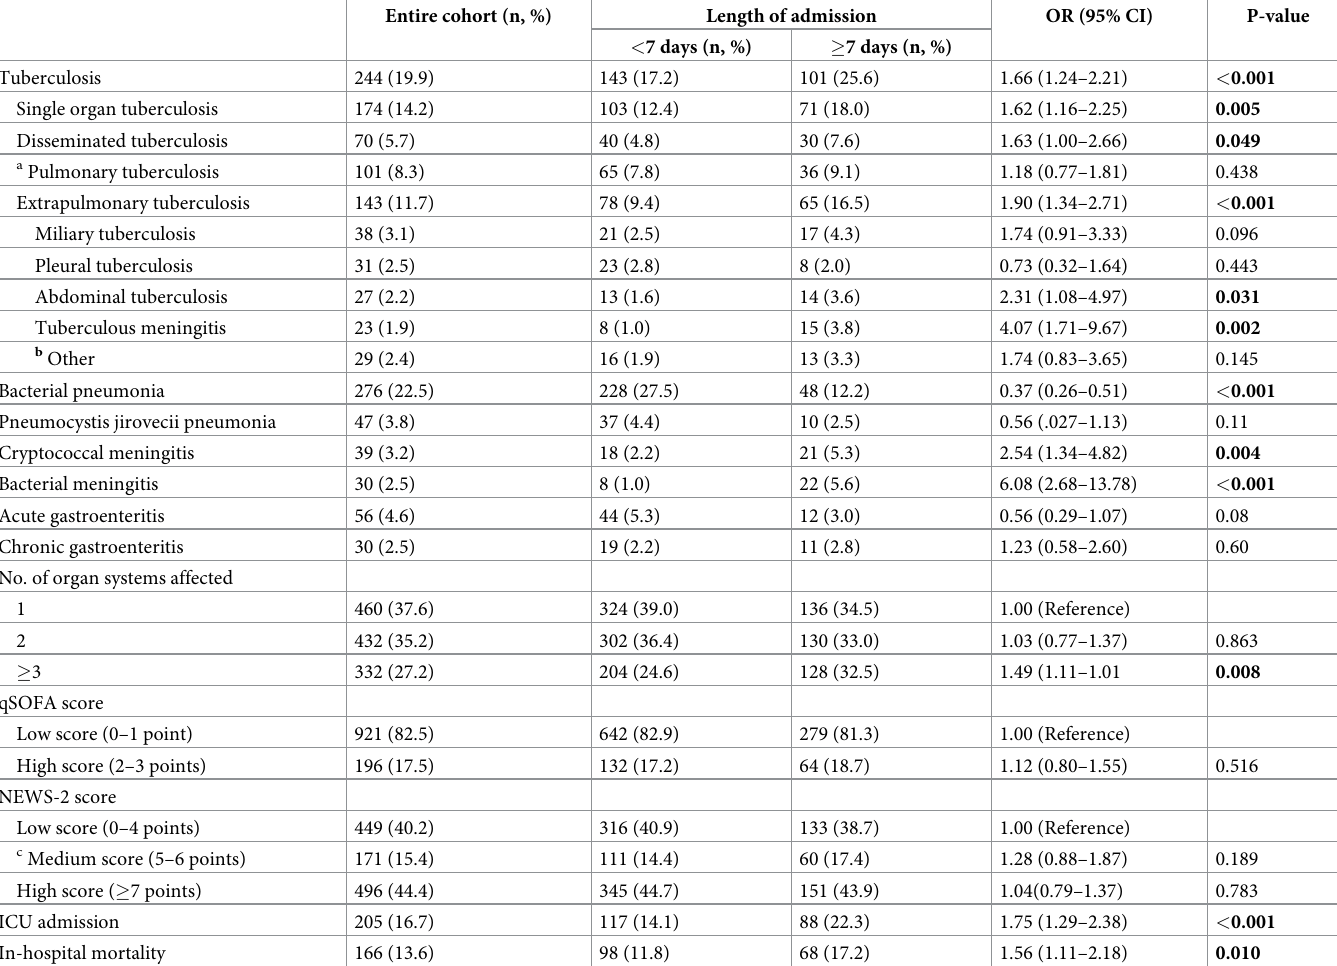
Table 2. Comparison of LOS with respect to common HIV related presenting diagnoses, illness severity scores, ICU admission and in-hospital mortality of study